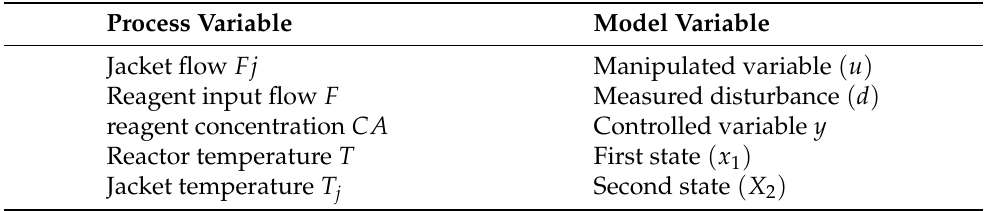
Table 2. Process input and output